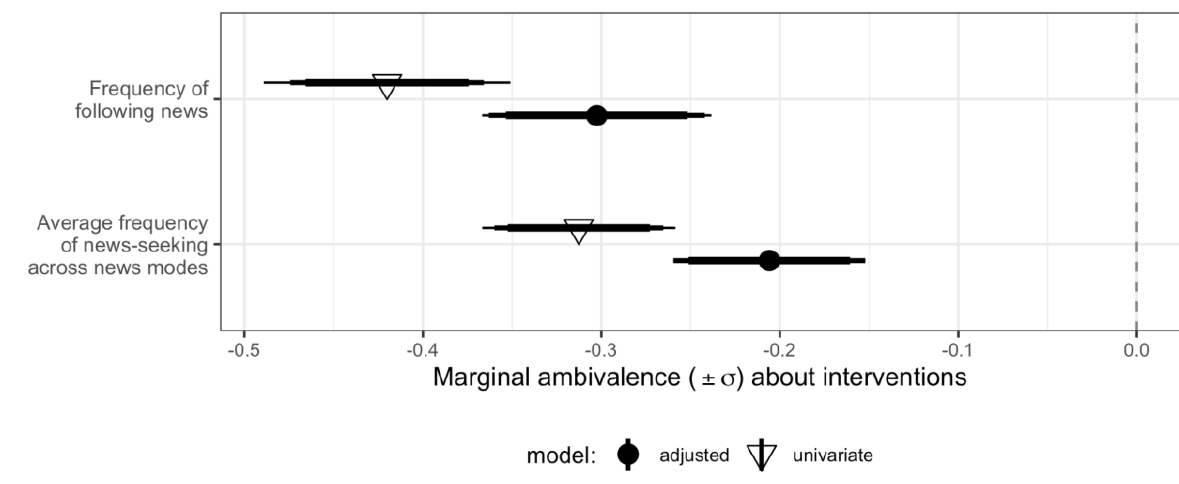
Figure 3. Association between news following and ambivalence towards interventions. This plot shows that, with and without covariate adjustment, frequency of following news (measured with a direct question a 6-point discrete scale) and average frequency across news modes (measured with a 6-point discrete scale for different news modes including tablet, desktop, mobile, radio, print news, local TV news, national TV news) predicts 0.2-0.4 standard deviations of lower ambivalence about misinformation interventions (aggregated across all questions in support